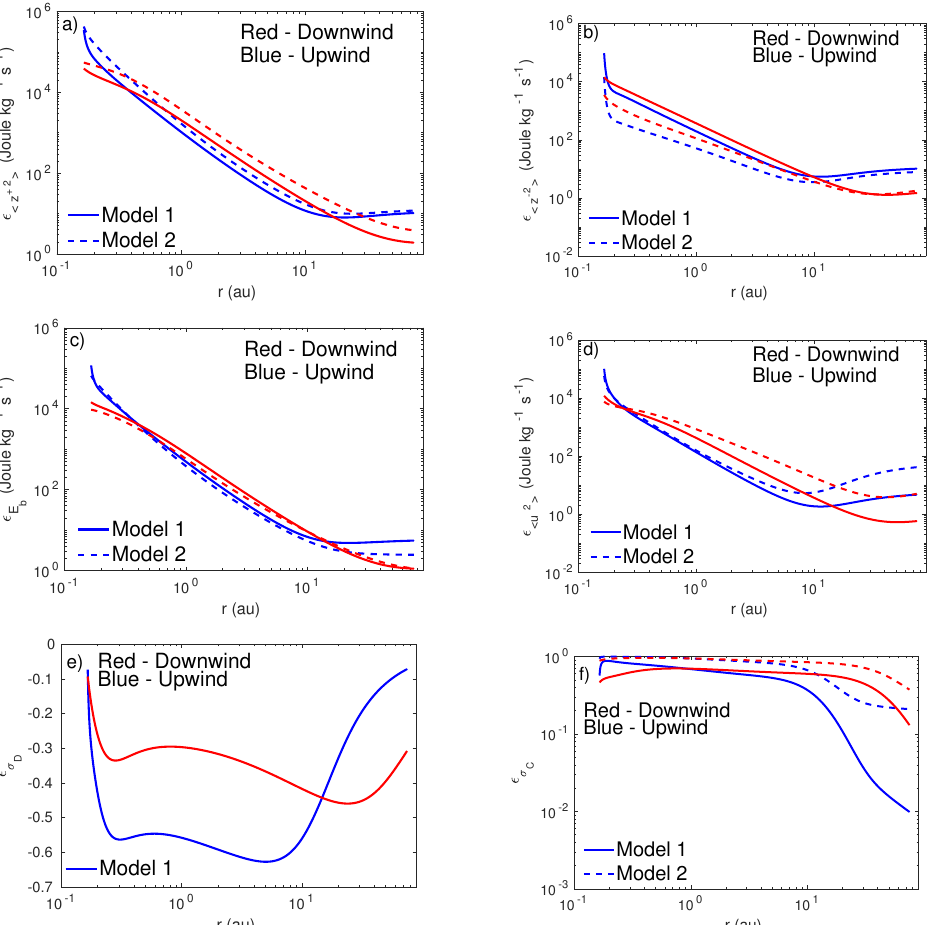
Figure 6. The turbulence cascade rate as a function of heliocentric distance. Panels ( a – f ) show the turbulence cascade of the energy in forward propagating mode, the energy in backward propagating mode, turbulent kinetic energy, normalized cross-helicity, normalized residual energy, and turbulent magnetic energy density as a function of heliocentric distance, respectively. The blue and red curves denote the turbulence cascade in the upwind and downwind directions, respectively. The solid and dashed curves represent the turbulence cascade calculated by models 1, and 2, respectively. Panel (e) of Figure 6 shows the turbulence cascade rate of the normalized residual energy (cid:101) σ as a function of heliocentric distance. The (cid:101) σ in the downwind direction (solid D D and dashed red curves) is larger than that in the upwind direction (solid and dashed blue curves) from 0.17 au to 20 au, and then it reverses. Model 1 produces a negative (cid:101) σ